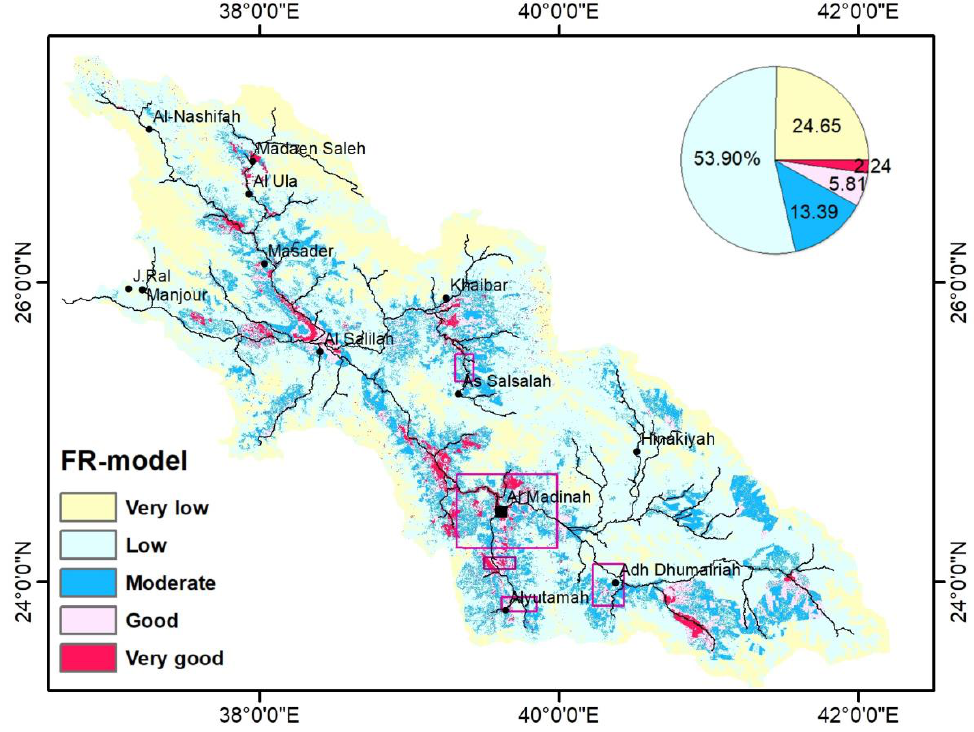
Figure 8. Groundwater potential zone map using FR-model and validated field data.